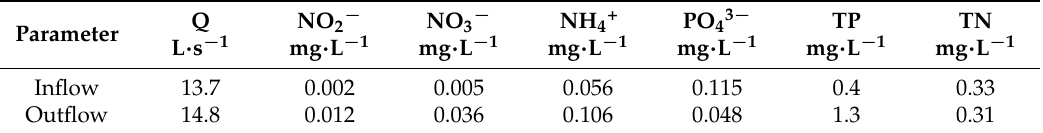
Table 2. Hydrochemical conditions of water of inflow and outflow waters, Q, discharge.